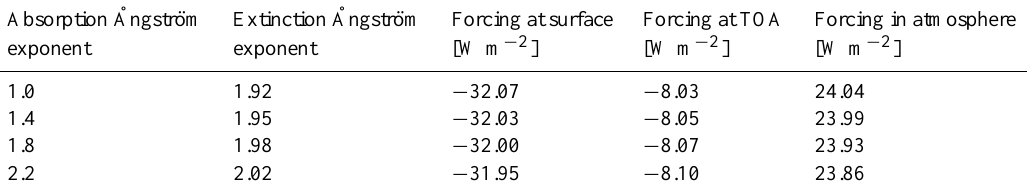
Table 3. First-order estimate of the 24h radiative forcing between 450 and 880nm at the surface, top of atmosphere (TOA), and in the atmosphere, considering AOT=1.0 and different spectral dependencies for the absorption coefficient. Absorption ˚Angstr¨om Extinction ˚Angstr¨om Forcing at surface Forcing at TOA Forcing in